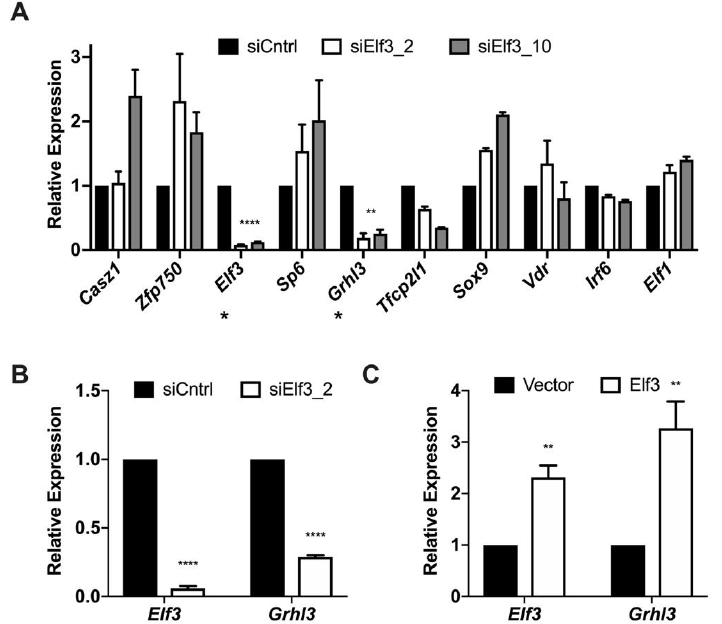
Figure 4. Grhl3 expression levels change in response to modulating Elf3 expression in different cellular models. ( A ) NMuMG cells recovering from TGF β 3 treatment were transfected with either control